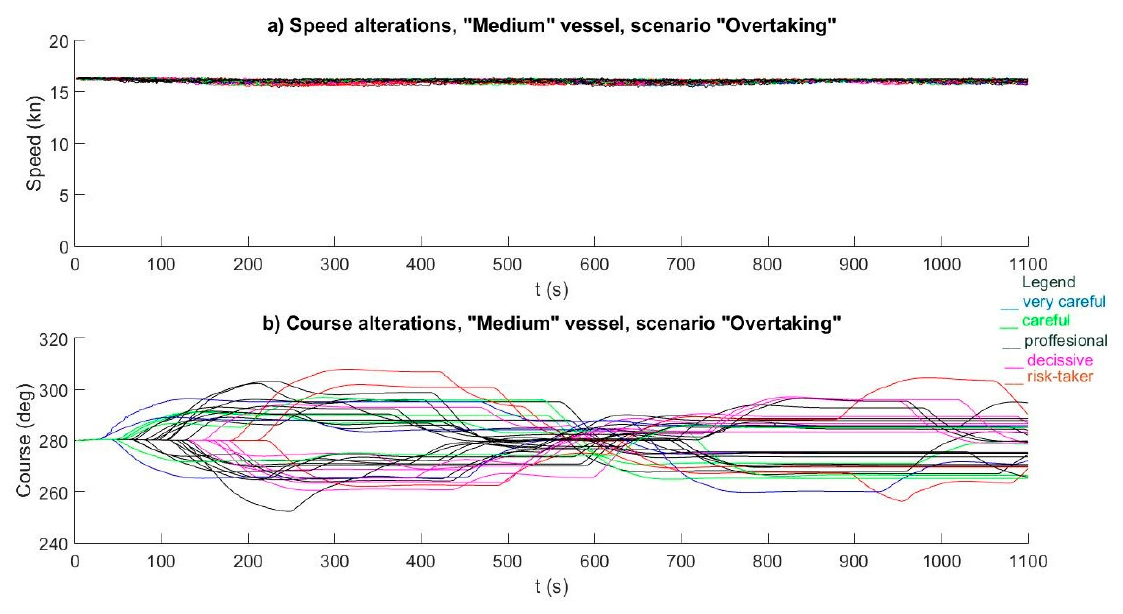
Figure 7. Alterations of speed and course. Medium ship, ‘Overtaking’.